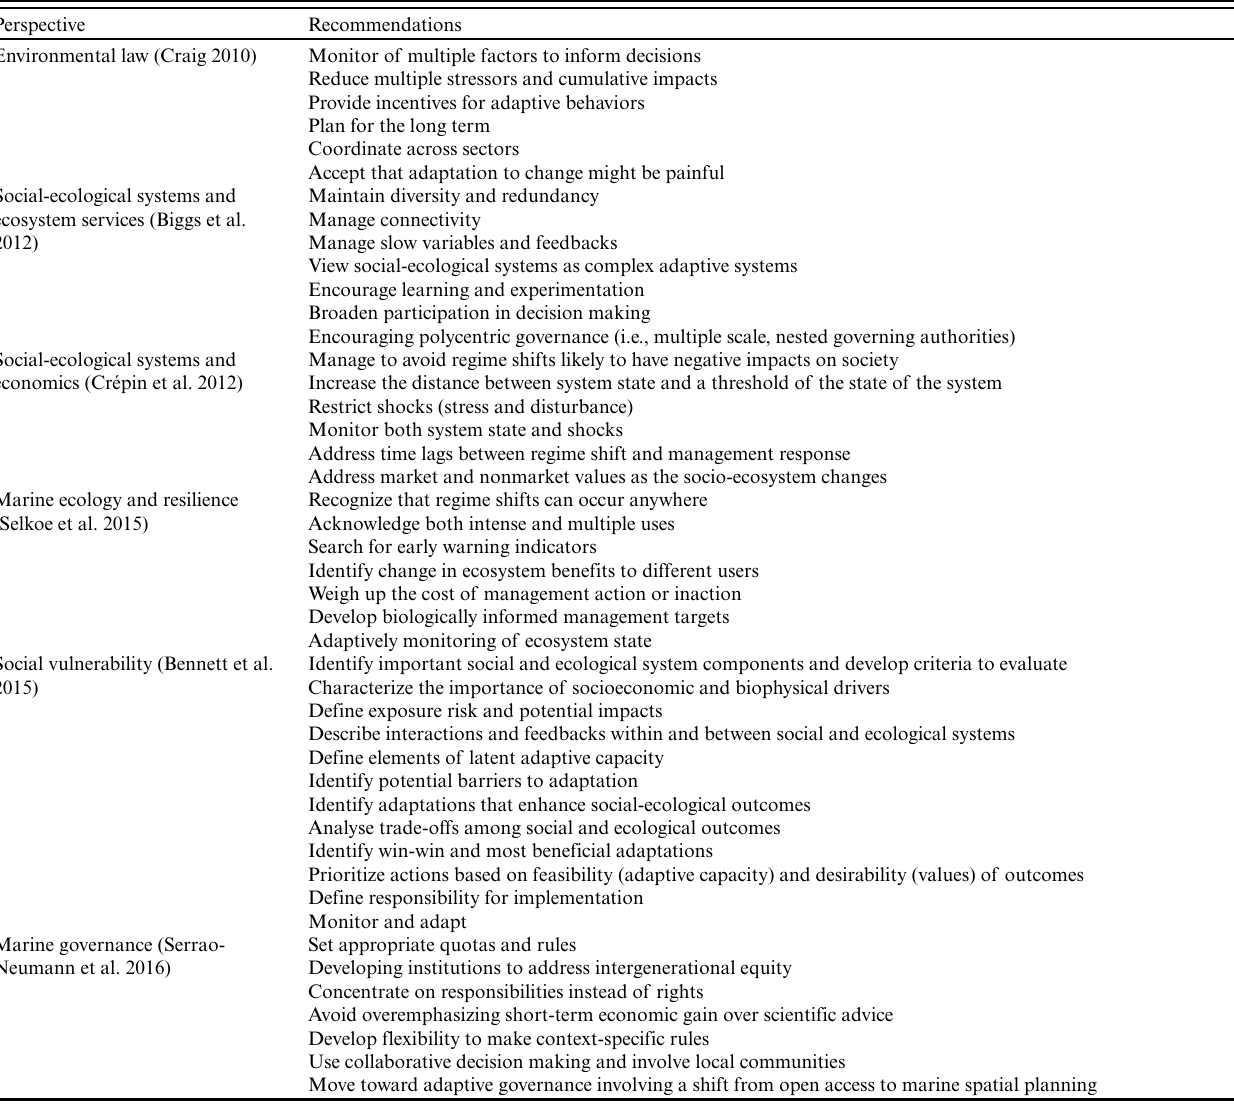
Table 1 . Recommended actions to address regimes shifts derived from different perspectives of science, governance, and society.